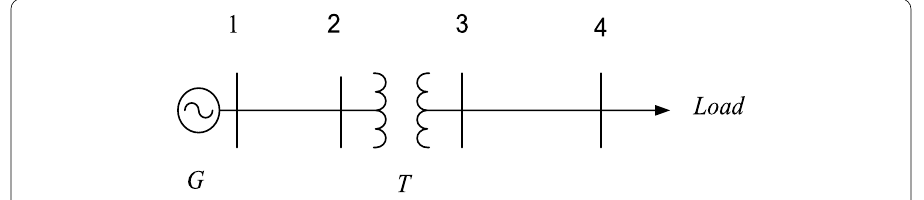
Fig. 14 IEEE 4 feeder test system; IEEE 4 feeder test system consists of four nodes, a generator, a transformer, two lines and a